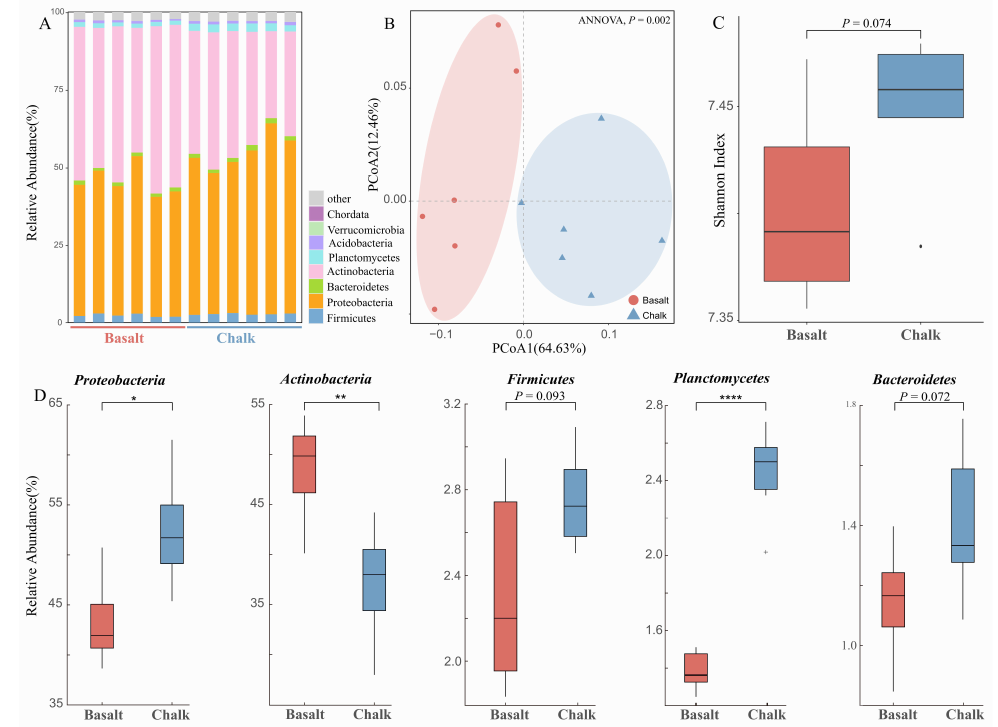
Figure 2. The taxonomy analysis of soil microbiomes and relative abundance of the two soil types. ( A ) Bacteria composition, which shows the most abundant species are from Actinobacteria and Proteobacteria. ( B ) Principal component analysis shows the bacterial composition of the two soil types was clearly separated. ( C ) Comparison of community diversity measured by Shannon diversity, showing it was higher in the arid chalk than that in the clayey wetter and milder basalt soils. ( D ) The relative abundance of the five dominant phyla. In this figure, *, **, and **** indicates the significance levels p < 0.05, p < 0.01, and p < 0.0001